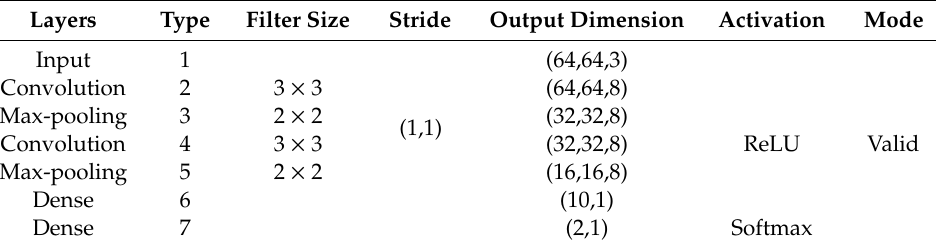
Table 4. Detailed architecture for the CNN.